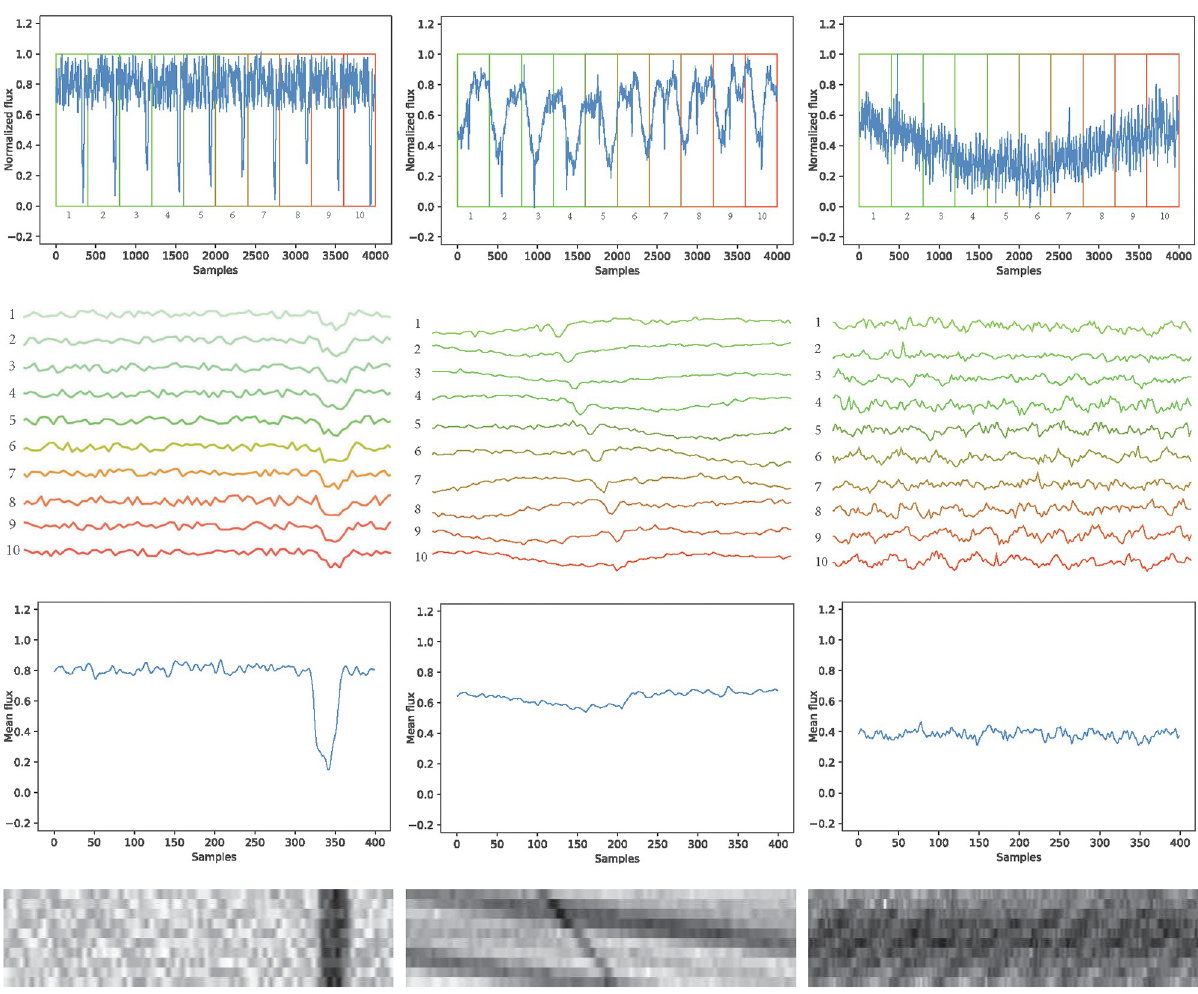
Fig 1. 2D Phase folding for three cases: Synthetic lightcurve (left). Real lightcurve with transit from the host star KIC7051180 (center). Real lightcurve without transit from the host star KIC757076 (right). generated by folding the light curve in 10 segments using the transit period from the catalog’s koi_period column, then the values for each period were incorporated as rows of an image. Fig 1 shows the 2D phase folding process on three examples of lightcurves: first column (left) shows a synthetic lightcurve with transit folded on the transit period, second column (center) shows a real lightcurve with unsuitable folding for the actual transit period, and third column (right) presents a real lightcurve without transit. First row of the figure presents the pre-processed light curve, a 1D signal of 4000 samples normalized to have values between 0 and 1. Ten folds of 400 samples each are enumerated. Second row of the figure shows a zoom view of each fold, the transit is visible on (left) at the same phase on each fold, since (center) has a folding period different from the transit period, the drops on each fold appears to be shifted to a lightly different phase than in the previous one, on (right) no transit drop is visible on any fold. Third row of the figure presents the mean of the 10 folds on each case, this would be the inputs of the [16] proposed model, i.e. a 1D vector of 400 samples. The transit is visible on (left) closer to the 350 sample, on (center) the mean transit signal becomes unclear and the